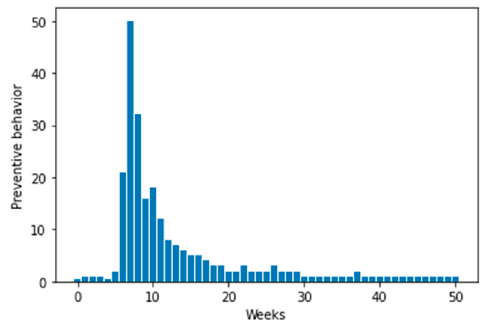
Figure 1. Time series of public protection behavior.